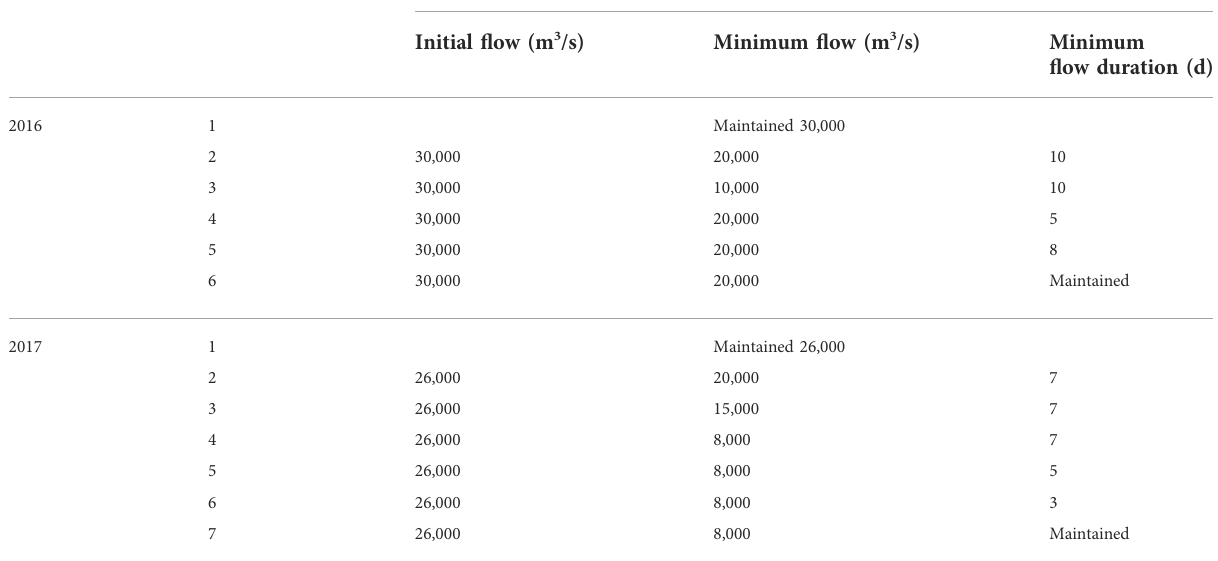
TABLE 3 Upper boundary settings of different scenarios of reduced out fl ow discharge from the TGR.